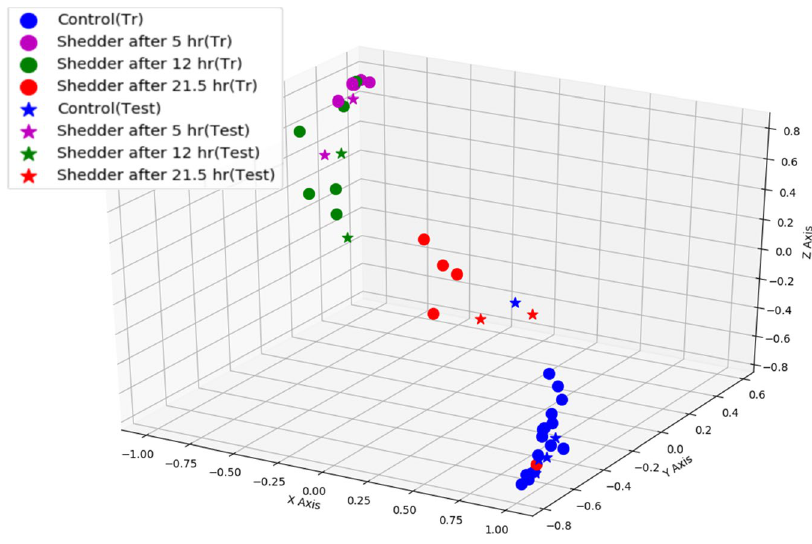
Figure 1. Visualizations of the α - β interferon signaling pathway on H1N1